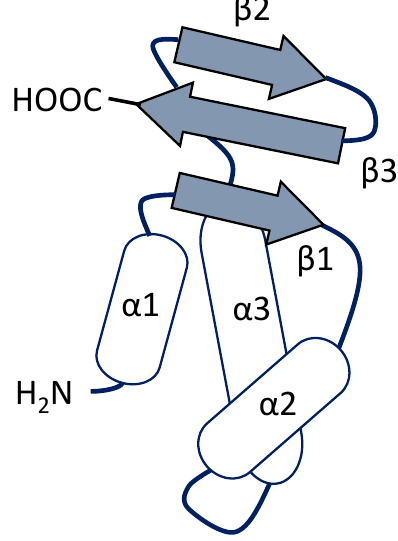
Figure 6. Topology of the winged helix domain.